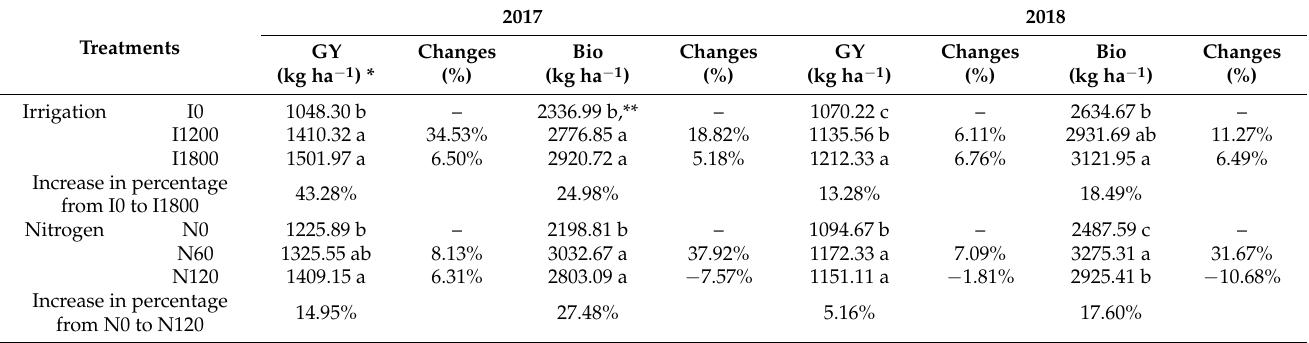
Table 2. Effects of different irrigation and nitrogen application on grain yield and biomass of oilseed